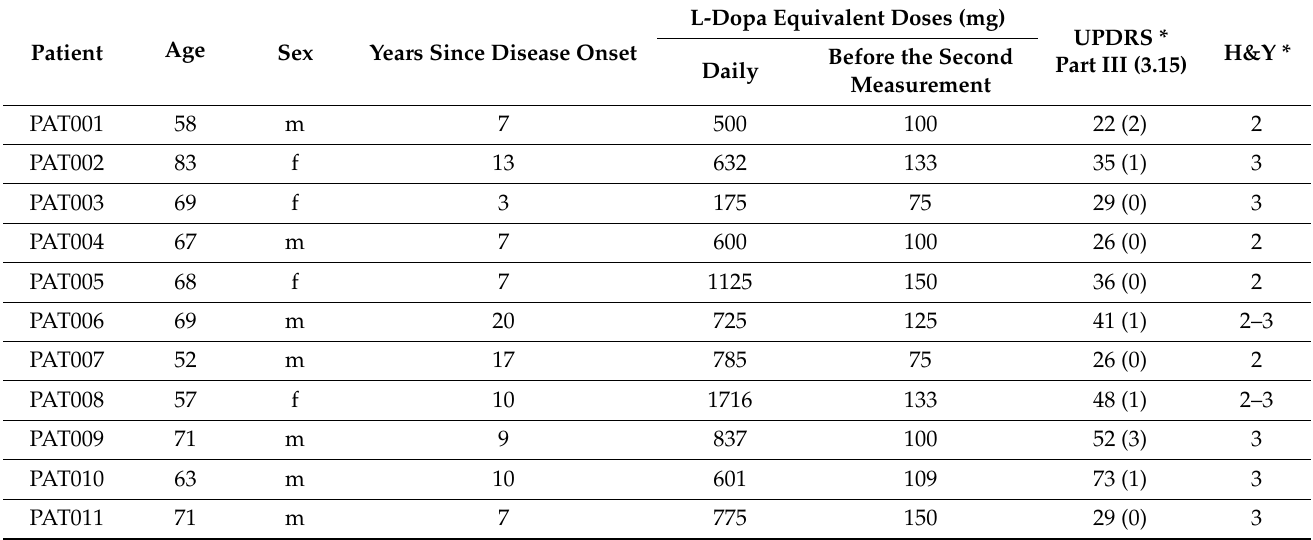
Table 1. Extended patient